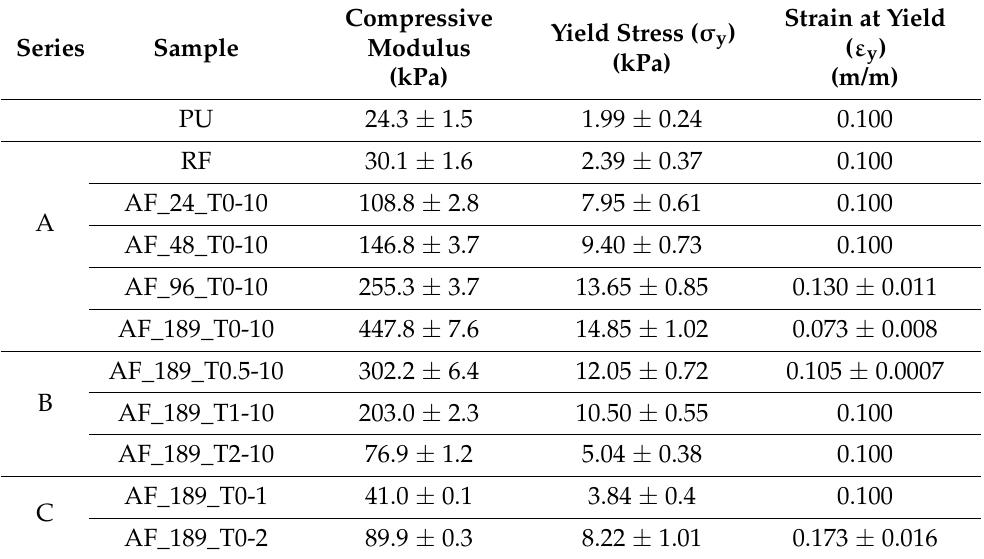
Figure 7. Representative stress–strain curves of foams as function of: ( A ) magnetic field strength, ( B ) sON, ( C ) sOFF. Table 2. Compressive Young’s Modulus, yield stress, and yield strain of samples (reported as average ± error).